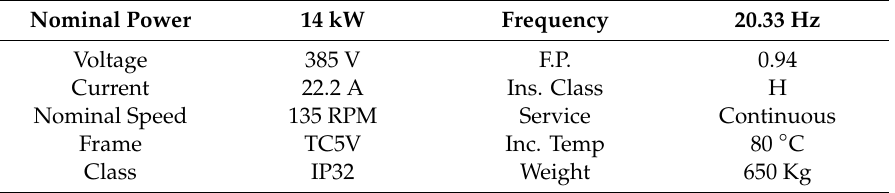
Table 1. Permanent magnet synchronous generator (PMSG) specifications.